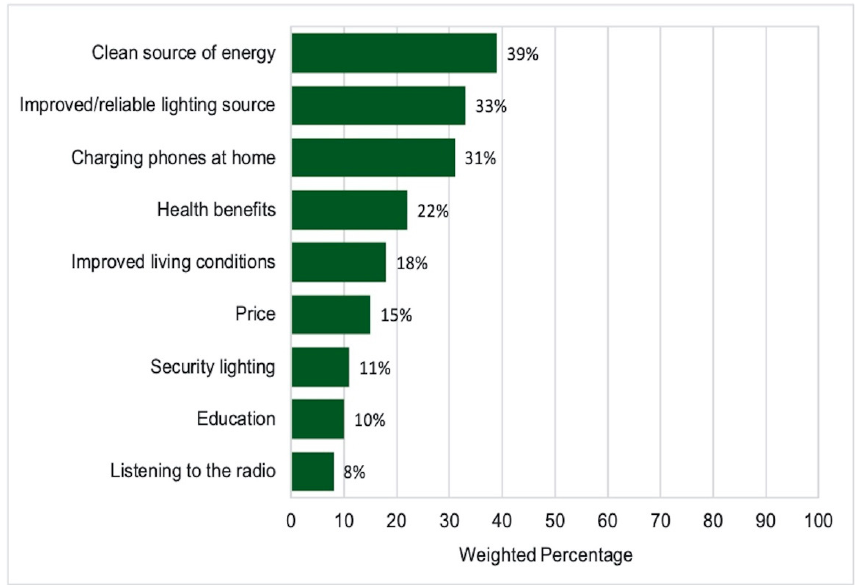
Figure 4. Weighted percentage of customer’s most important sign-up